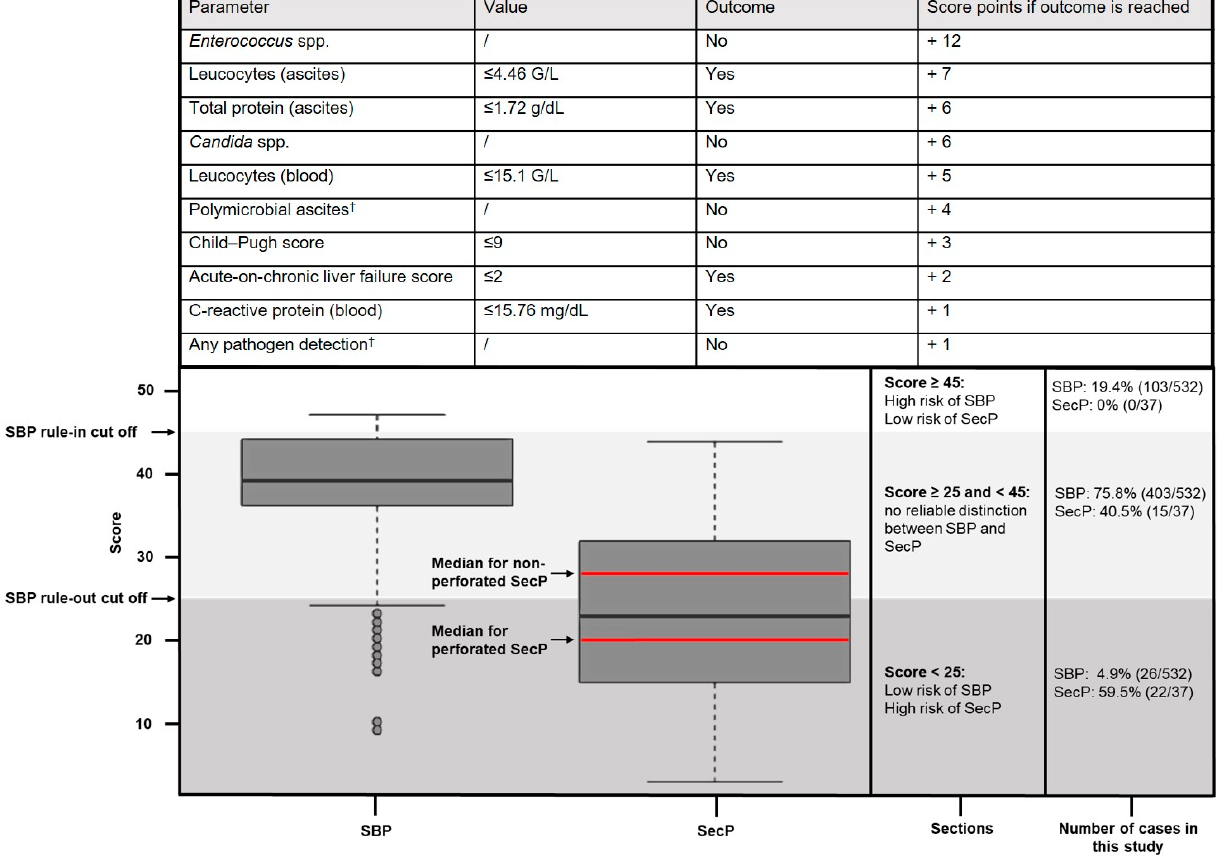
Figure 3. Point score model including a rule-in cut off (score ≥ 45) and a rule-out cut off (score < 25) for SBP, dividing the study patients into a low-risk and high-risk group for SecP. † Except coagulase negative Staphylococcus spp.; median scores for the subgroups of SecP (perforated and non-perforated SecP episodes) illustrated in red.